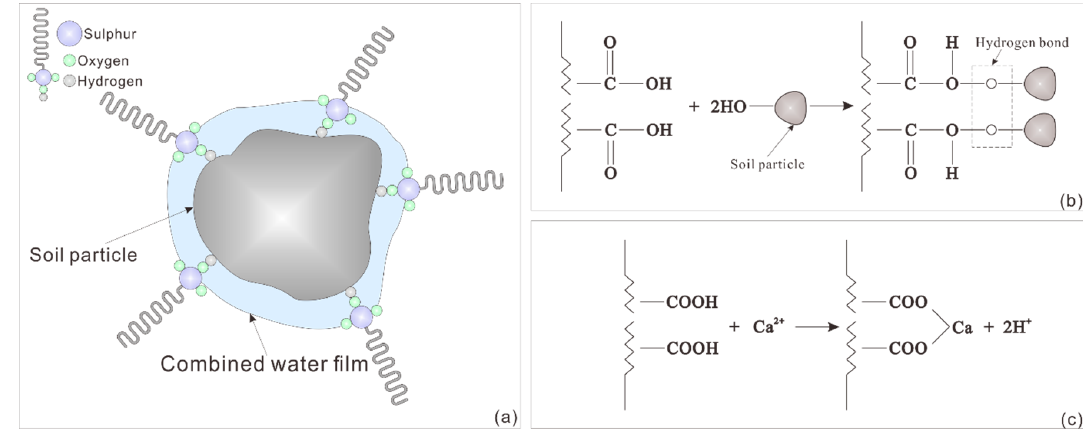
Figure 2. The interaction between polymer and soil particle: ( a ) Schematic diagram; ( b ) formation of hydrogen bonds; ( c ) cation substitution reaction.